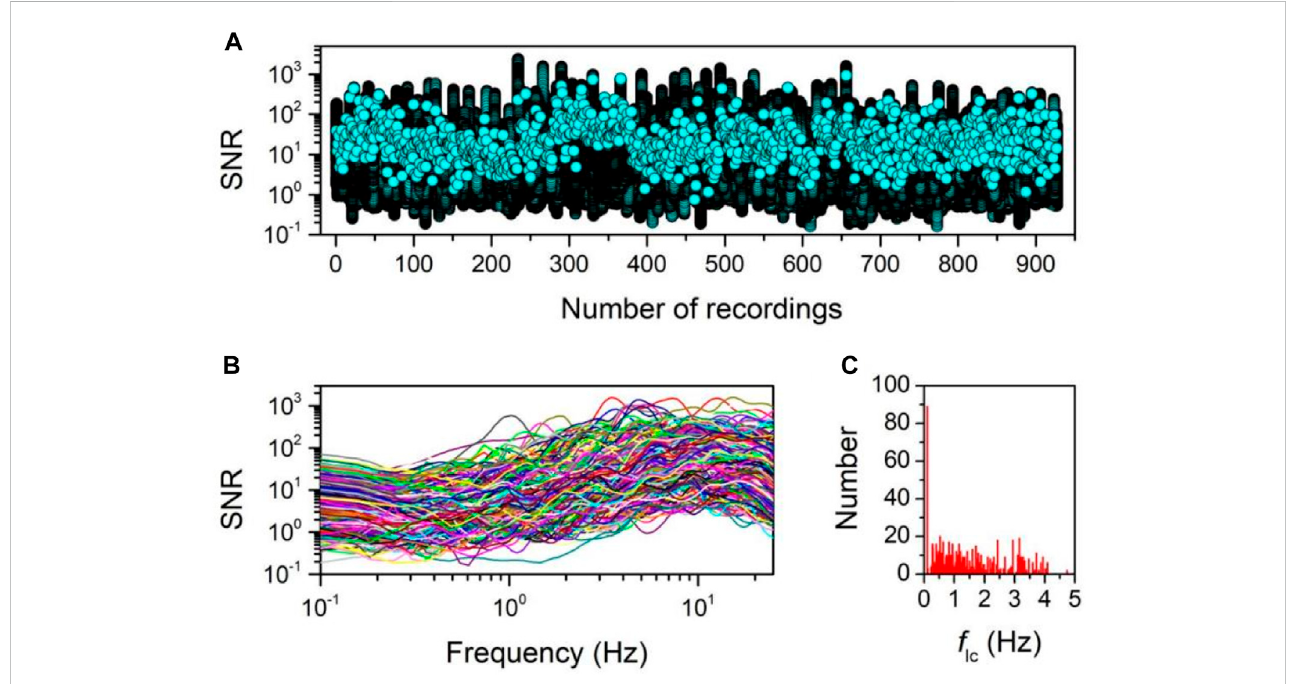
FIGURE 2 (A) The SNRs of the recordings considered in this study. (B) SNRs of each recording in frequency domain. (C) Histogram distribution of f lc determined according to